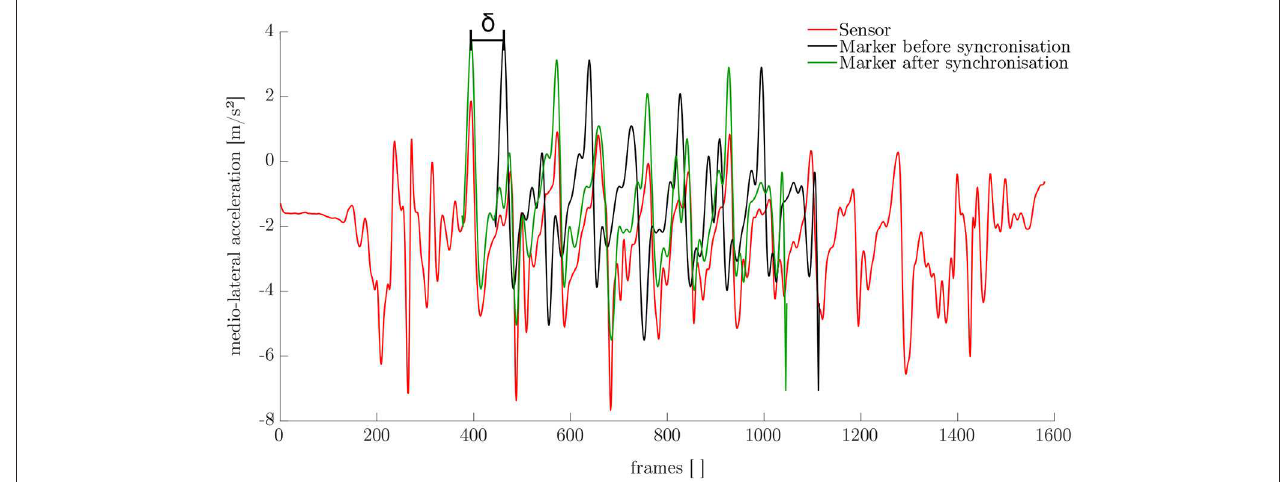
FIGURE 4 | Results of the synchronization based on the medio-lateral acceleration of the